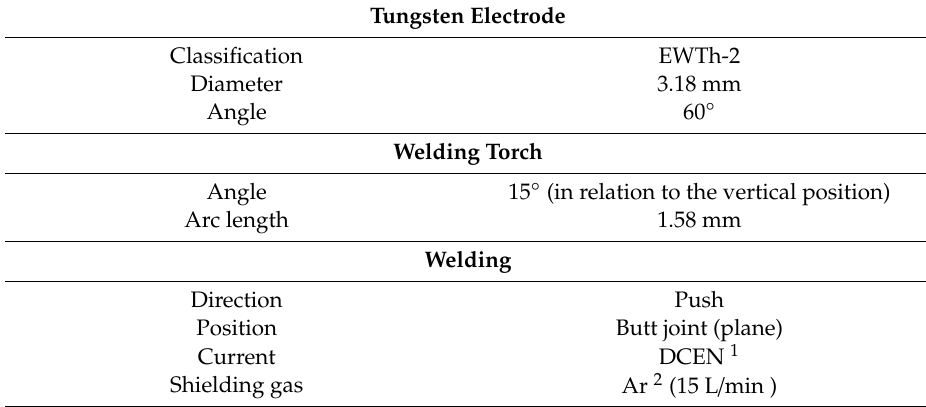
Table 3. Constant parameters of the gas tungsten arc welding (GTAW) manual process.